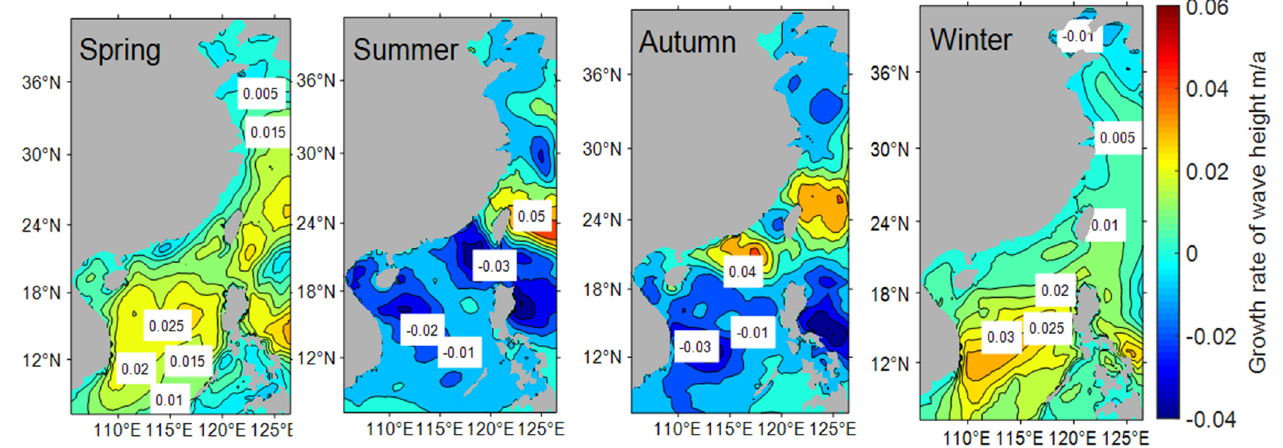
Figure 12. The distribution of seasonal mean growth rate of extreme wave height.